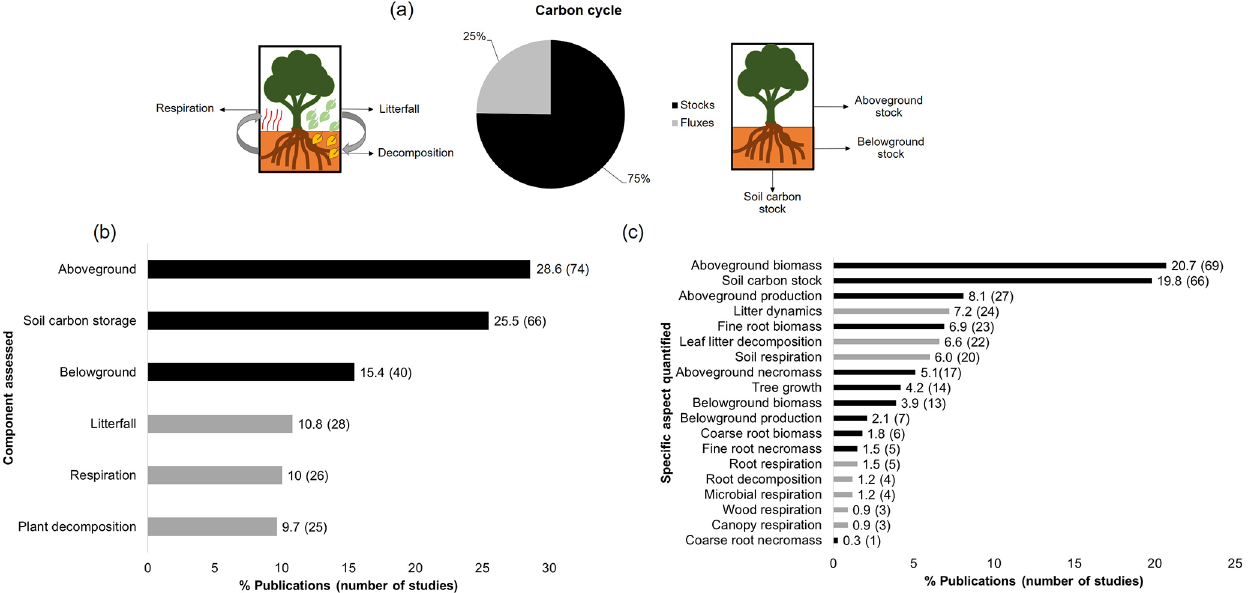
Figure 5. Information on the carbon cycle in tropical upland ecosystems. (a) Percentage of studies that estimate carbon stocks and fluxes, (b) assessed component of the carbon cycle, and (c) specific aspect quantified. The colours represent the evaluated functions (carbon stocks,